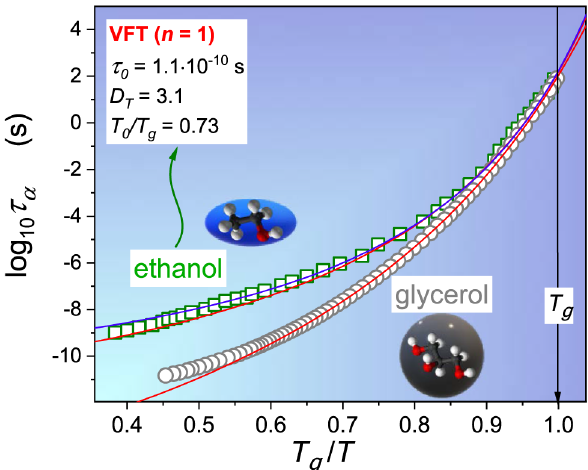
Figure 3. Evolutions of primary relaxation time for ethanol and glycerol presented in Angell plot. For glycerol T g = 187.7 K and ethanol T g = 98.1 K . Experimental data in the central part of the plot are portrayed via the VFT Eq. (2) (in red) and the generalised VFT Eq. (13) (in blue), basing on the fitting domain 0.16 < T g / T < 1 . Data obtained from Ref. 51–53 . Molecular structures taking from Wikimedia Commons.